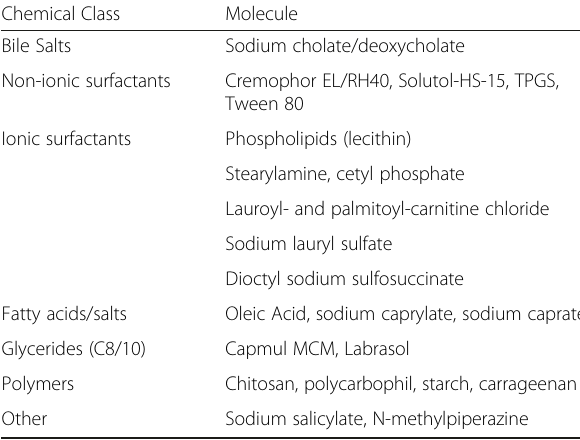
Table 1 Intestinal Permeability Enhancers (Aungst 2012; Whitehead et al. 2008; Maher et al. 2009)